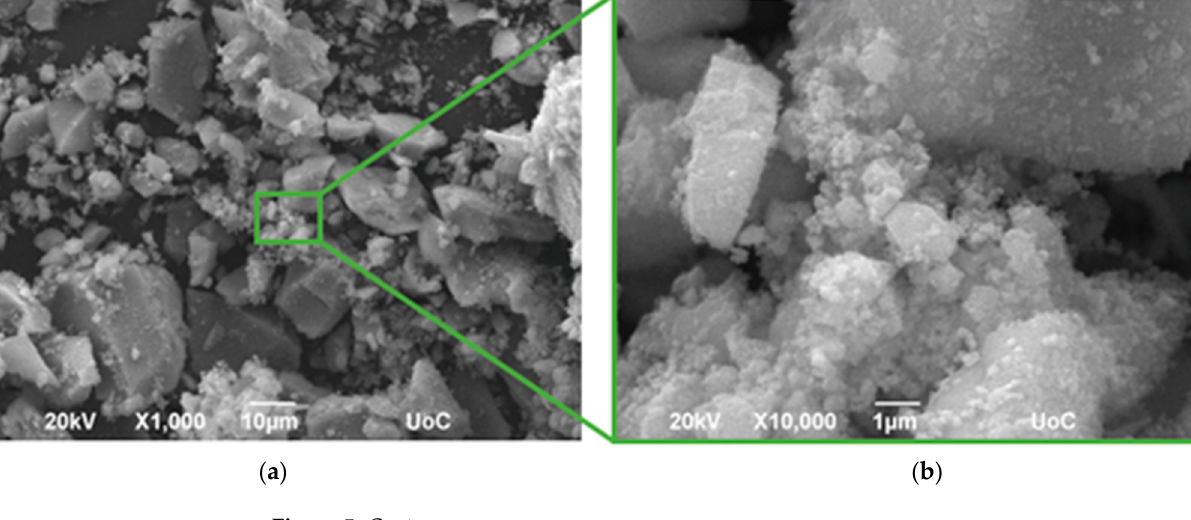
Figure 4. TEM images of ( a , b ) TC50 and ( c , d ) TC75 nanocomposites. Indeed, SEM was used to display the surface morphology of TC25 and TC62.5 nano- composites (Figure 5). Both nanohybrids consist of nearly spherical in shape, rough and compact aggregates with crystal structures and various diameters. The spherical-like shape is typical for anatase crystallite structure [10].